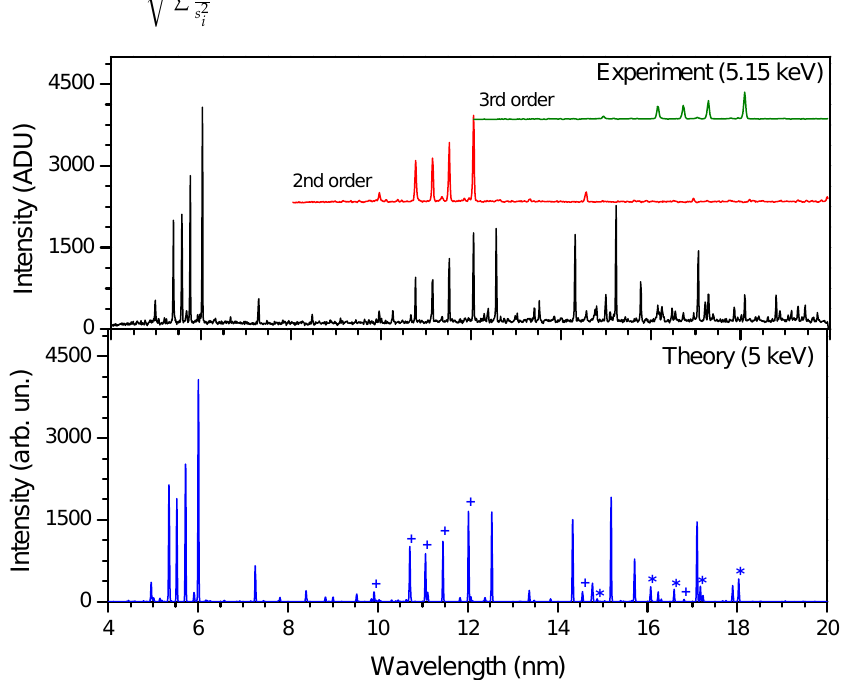
Figure 2. Comparison of the experimental spectrum ( top ) of yttrium with the theoretical spectrum ( bottom ). The intensity is given in analog to digital units (ADU) for the measured spectra. The second and third order spectra for the experimental data are also shown (red and green insets, respectively). The theoretical spectrum includes the second (+) and third ( ∗ ) order spectra and is calculated at an energy of 5 keV for the electron beam energy of 5.15 keV, to account for the space-charge correction in the